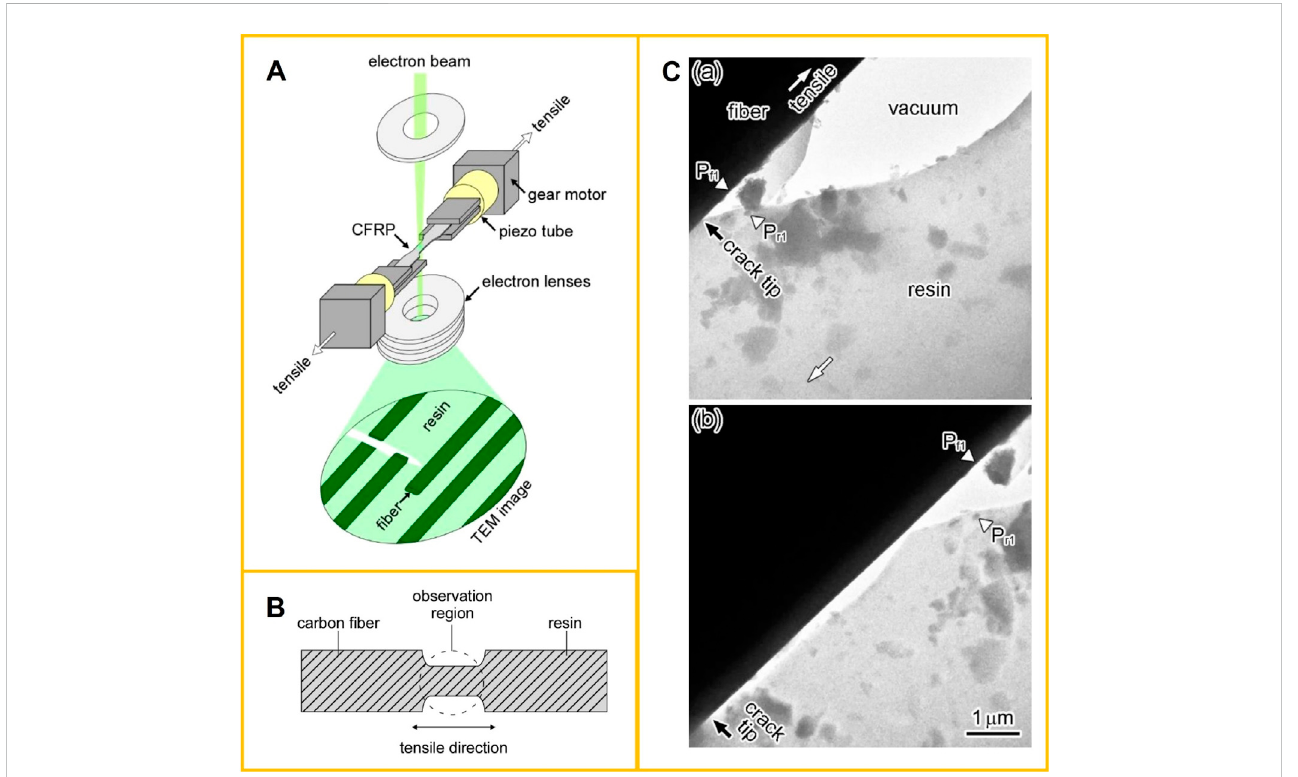
FIGURE 12 (A) Schematic of the in-situ TEM experimental system for the tensile deformation tests. Reprinted with permission from (Egoshi et al., 2020). Copyright 2020ElsevierB.V. (B) SchematicofCFRPsamplesfor insitu TEMoftensiledeformationtests.Reprintedwithpermissionfrom(Ishikawaetal.,2020).Copyright 2020 Elsevier B.V. (C) Snapshot TEM images of a CF ’ s side surface ’ s separation process in a sizing treatment (ST)-CFRP at on-axis tension. The upper left and the lower right sides are a CF and the resin matrix, respectively. The white arrows indicate the tension axis. The black arrow indicates the position of the crack tip. Pf1 and Pr1 in (a) and (b) represent the same CF and resin matrix positions, respectively. The deformation speed was 1.5 nm/s. Reprinted with permission from (Egoshi et al., 2020). Copyright 2020 Elsevier